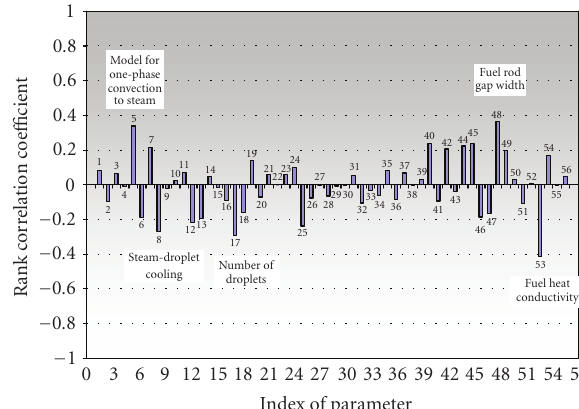
Figure 5: Sensitivity measures of the reflood PCT with respect to the selected 56 uncertain input parameters (rank correlation coe ffi - cient) for the reference reactor large